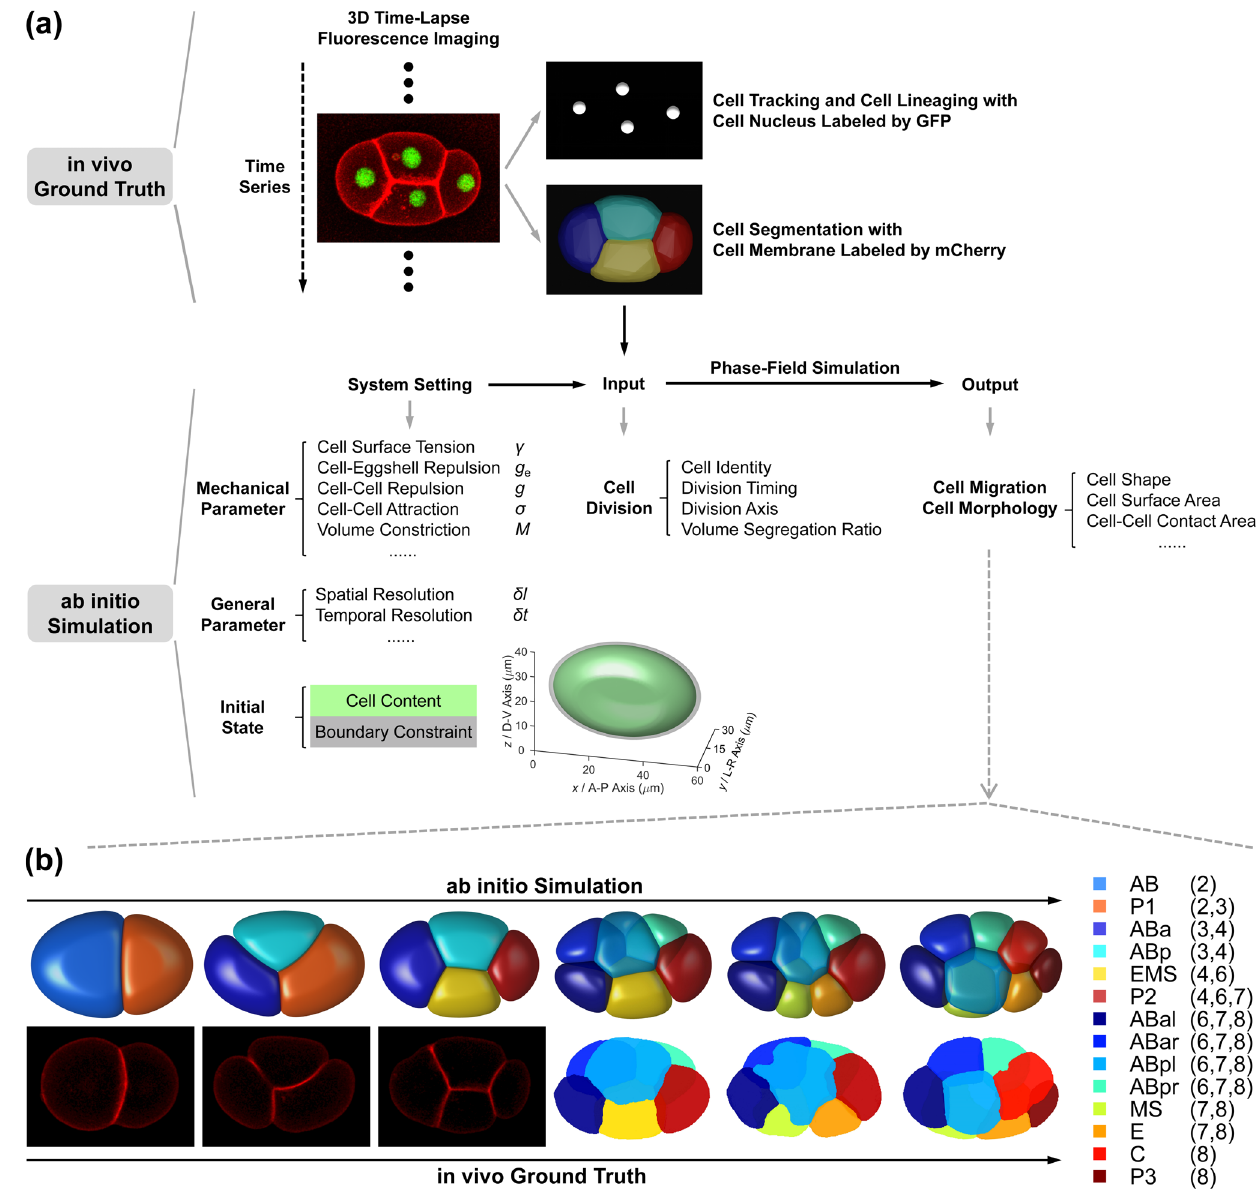
Fig. 1 The phase- fi eld framework for C. elegans early embryogenesis. a Flow chart. b Comparison between ab initio simulation and in vivo ground truth of C. elegans embryonic morphologies from 2- to 8-cell stages. The embryonic structures at 2-, 3-, and 4-cell stages are two- dimensional and shown by fl uorescence images; the ones at 6-, 7-, and 8-cell stages are three-dimensional and shown by segmented images. The cells ’ identities and corresponding colors and existing stages (represented by the total cell number of the stage) are denoted on the right. All the sub fi gures, except the schematics for the initial state setting in (a), are adapted from ref. 43 with granted